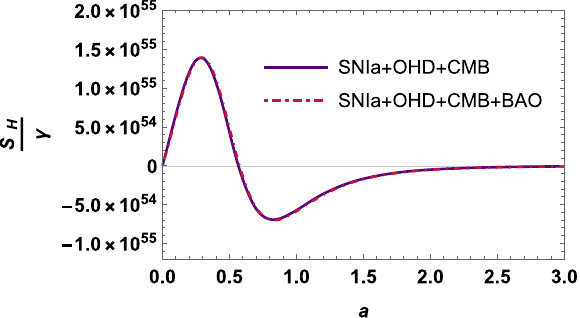
(cid:2)(cid:2) H γ with scale factor for the best estimated Fig. 12 The evolution of S values of the model parameters using the fourth and sixth